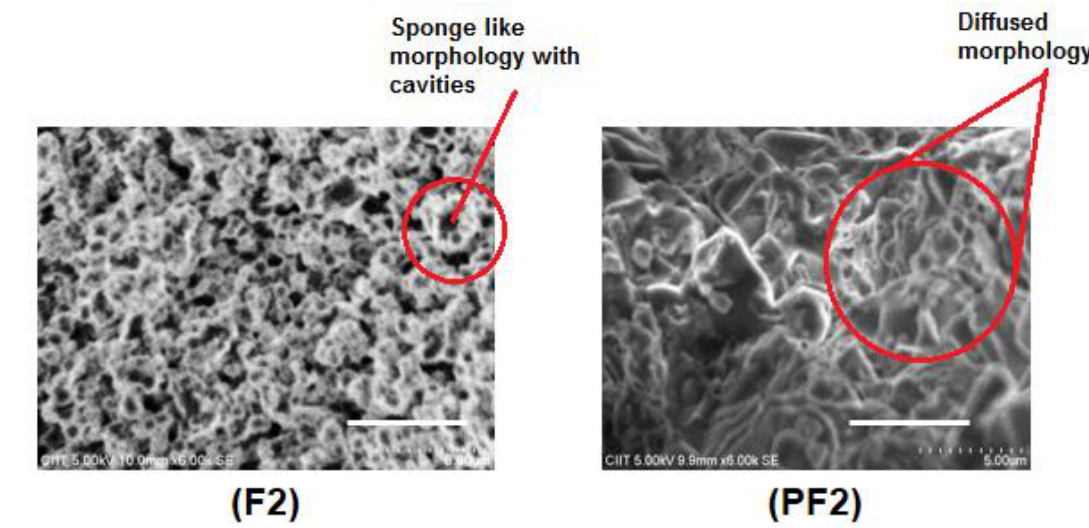
Figure 5. SEM images of the representative terpolyamides and their block copolymers, scale bar: 5 μm.